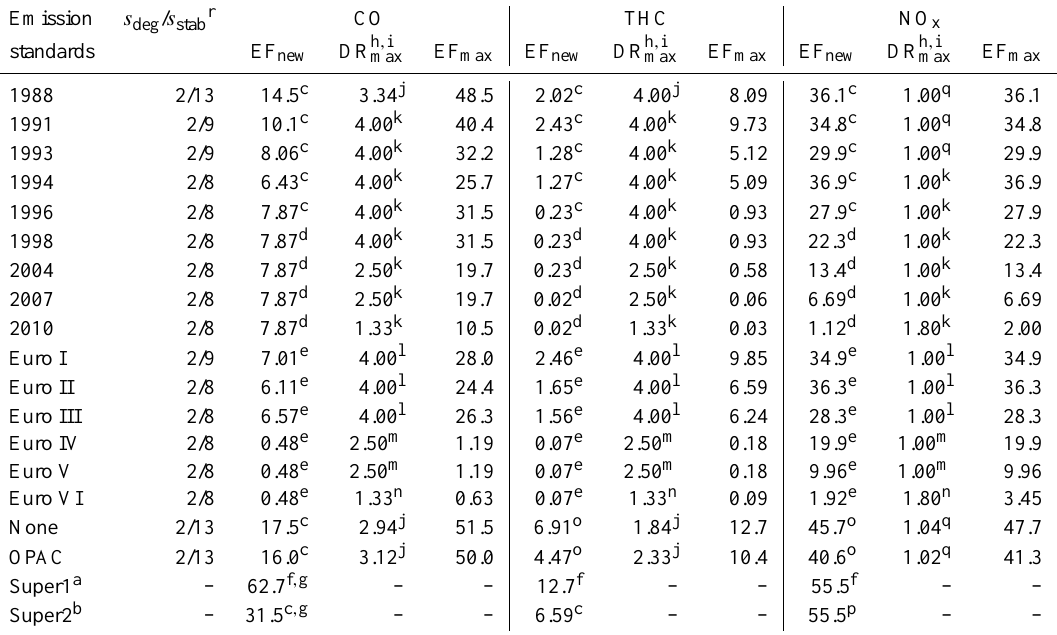
Table 4. Gaseous emission factors (unit: gkg − 1 ) and degradation rates for HDDVs. Emission s deg / s stabr